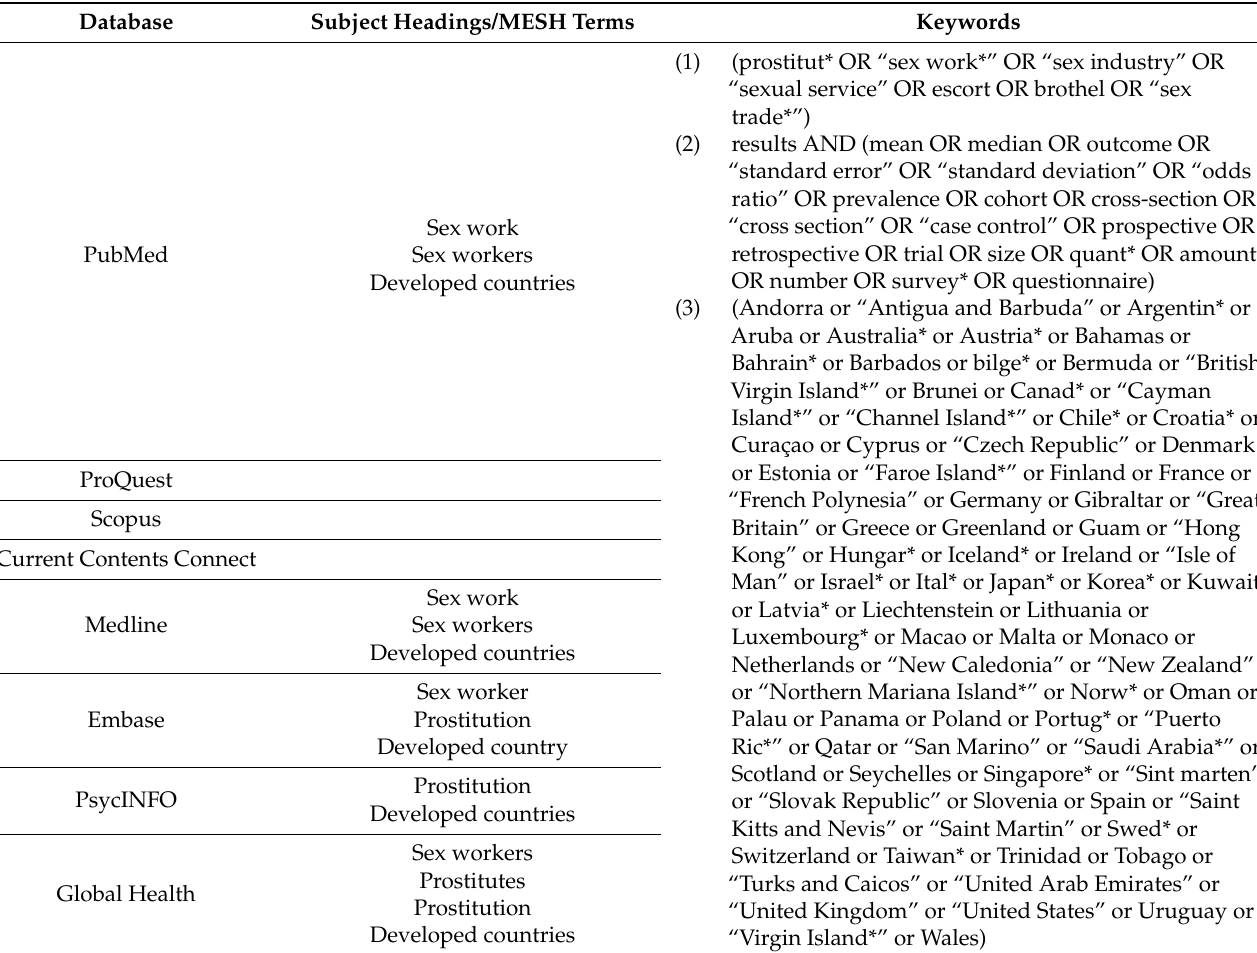
Table 1. Database search